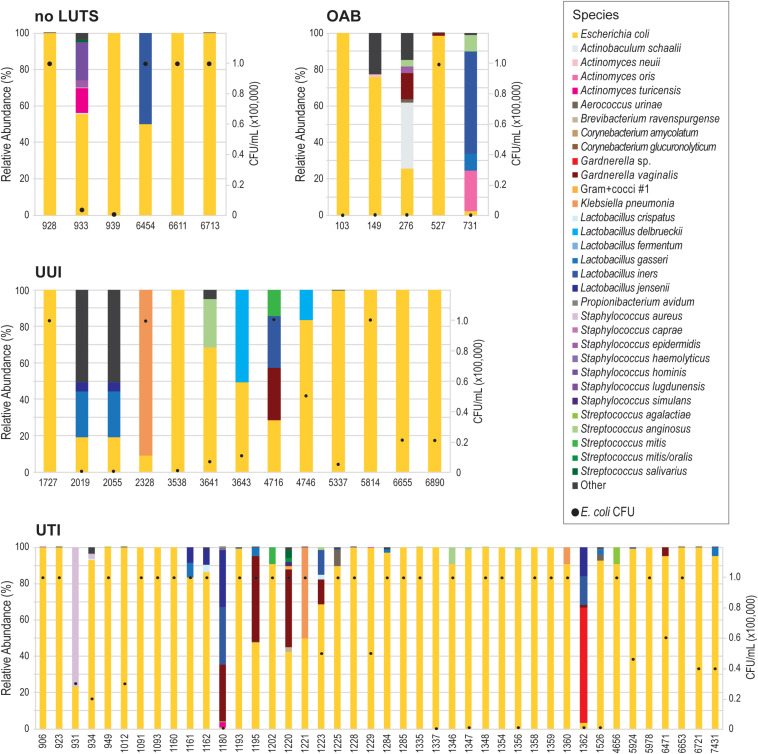
Urobiomes from which E. coli was isolated. Each bar represents the relative abundance of microorganisms within the urobiome, color coded by species, for the individual patient. The black circles on each stacked bar show the abundance of E. coli in the urobiome. Urobiomes are presented according to the symptom group.